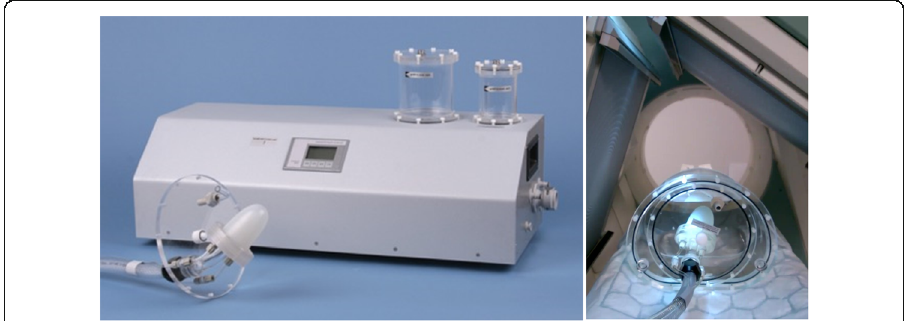
Fig. 1 The dynamic heart phantom. Left — the membrane and pump units. Right — the phantom assembled and ready for measurement in the gamma camera. The membrane unit installed is shown inside a NEMA IEC PET body phantom and positioned for IQ-SPECT